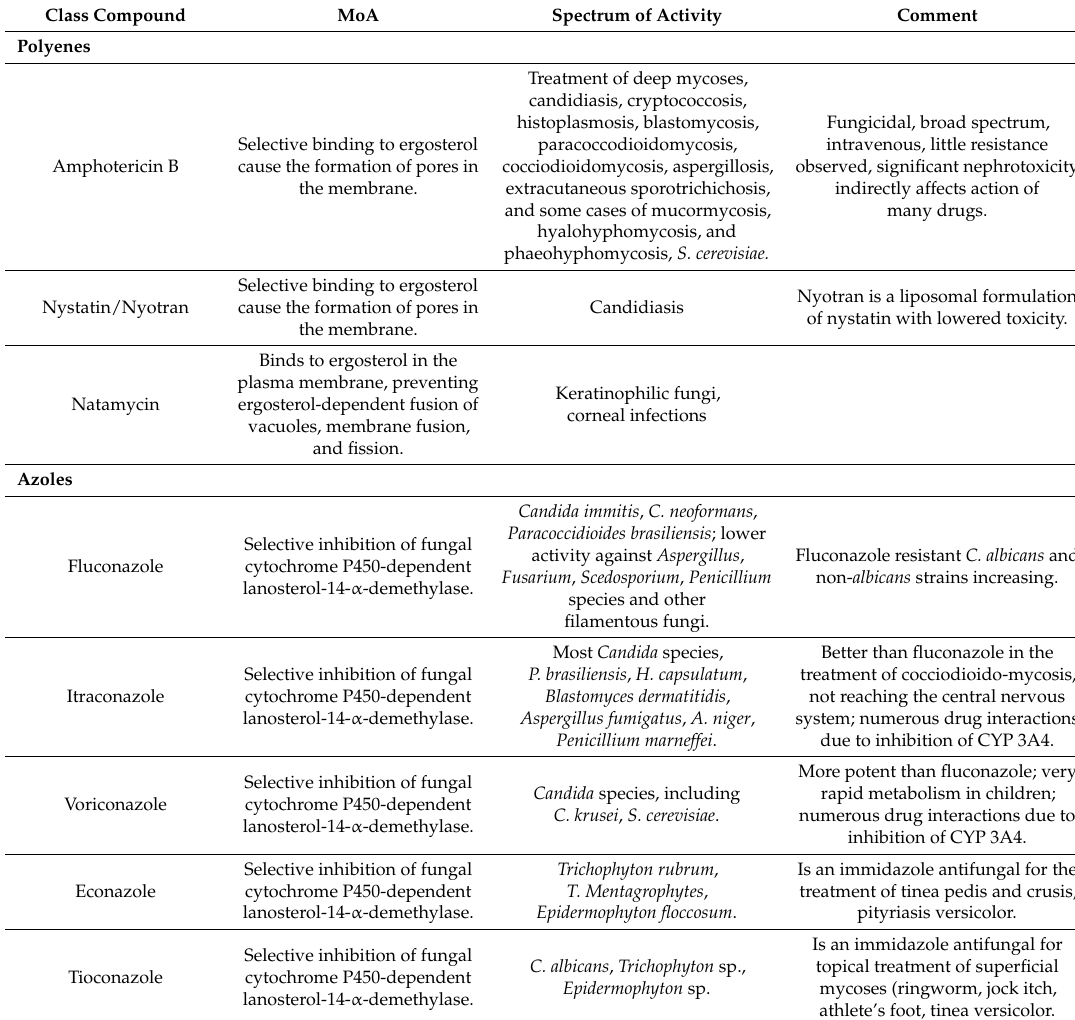
Table 1. Overview of the mostly used antifungal agents, mechanism of action (MoA), and spectrum of activity